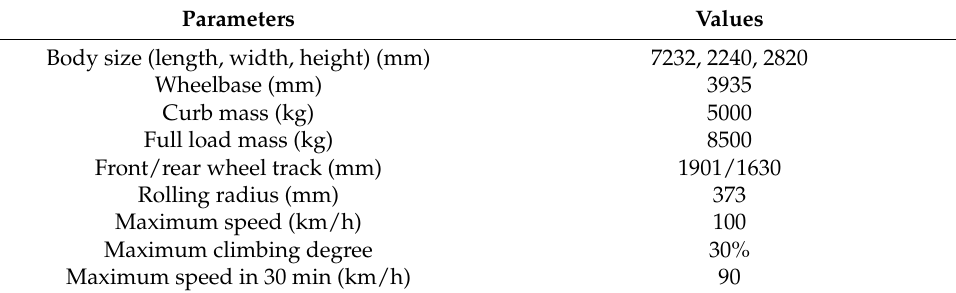
Figure 3. Schematic diagram of two kinds of gear meshing: ( a ) external meshing; ( b ) internal mesh- ing; and ( c ) load distribution coefficient. Here, the transmission efficiency 𝜂 (cid:3032)(cid:3051) of external meshing can be expressed as [40]: